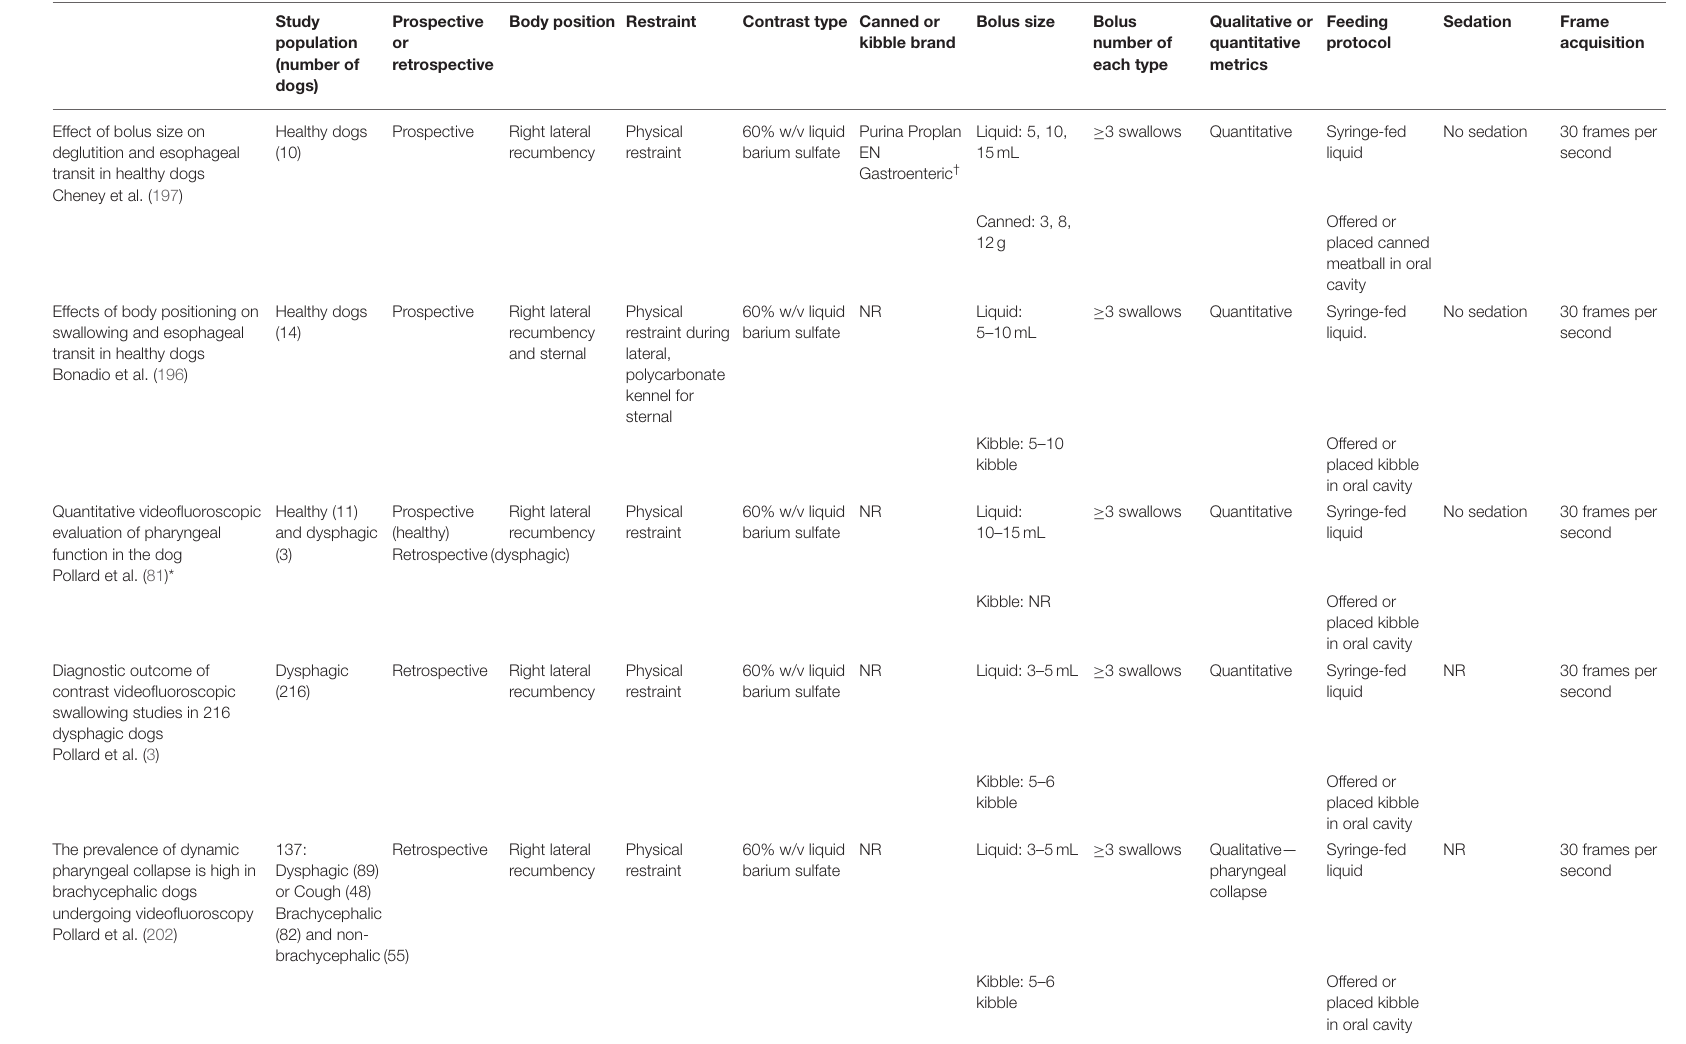
TABLE 2 | Swallow fluoroscopic study manuscripts in